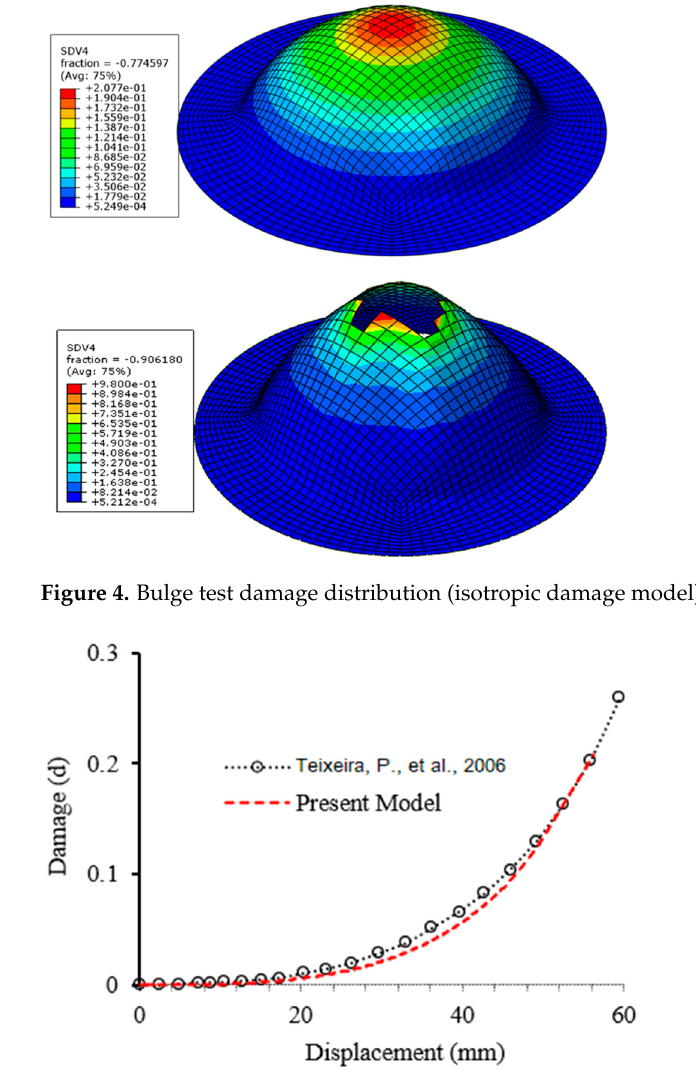
Figure 5. Damage evolution [31].